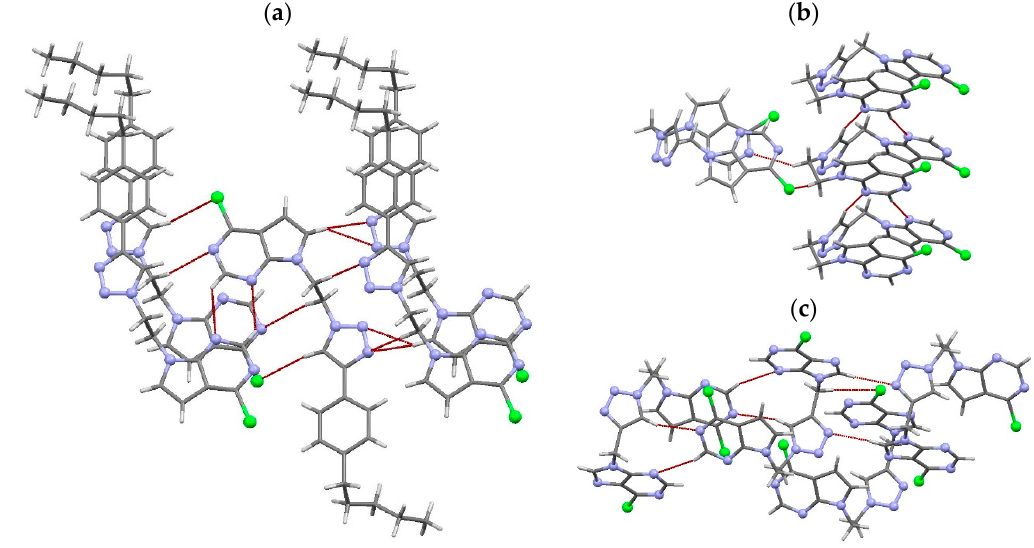
Figure 4. Capped stick representation of 4g ( a ), 5a ( b ) and 5b ( c ), showing C–H···N and C–H···Cl hydrogen bonds. Nitrogen and chlorine atoms are presented in ball and stick style. Color code: blue, N; green, Cl; grey, C; light grey, H.